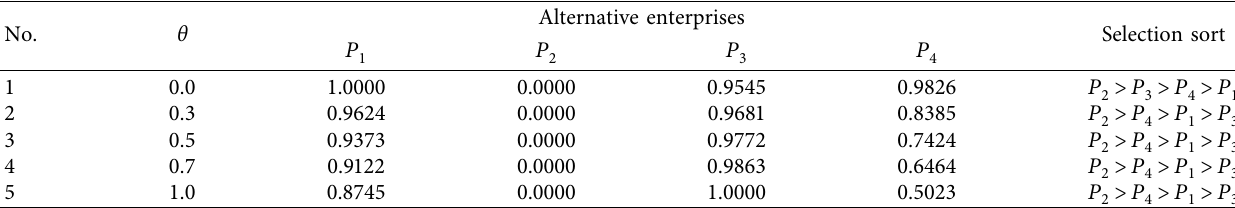
Table 7: Sensitivity analysis of the decision coefficient.